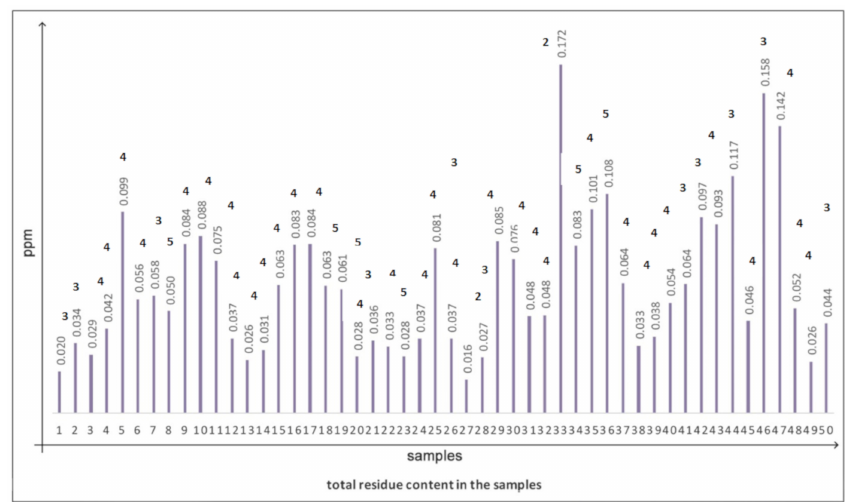
Figure 1. Total pesticide contents calculated as sums of the individual active substances found in the samples. All data are lower the MRL set in Italy for metalaxyl in wine (0.2 ppm, DM 27 / 08 / 2004). The number of active principles found in the samples are reported above the